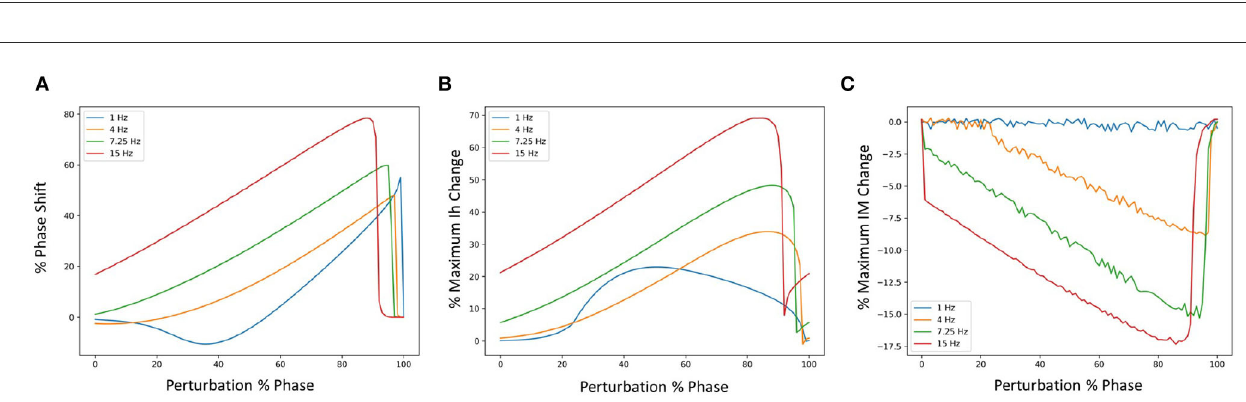
FIGURE3 Phase response curves (PRCs) using different firing frequencies of SINGLE. (A) Shows PRCs at 4 different frequencies and the corresponding phase-dependent changes of Ih (B) and IM (C) when inhibitory perturbations are applied to SINGLE firing at 1, 4, 7.25, and 15 Hz, due to injected currents of 25.5, 35.1, 47.4, and 75.7 pA, respectively. Responses are similar to those obtained by Guet-McCreight and Skinner